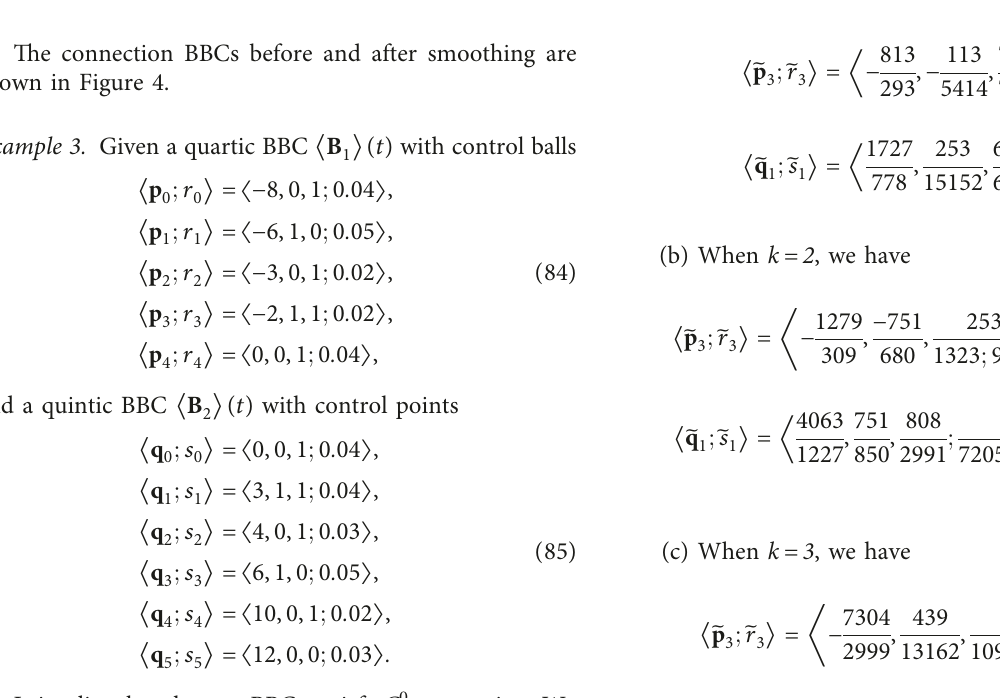
Figure 4: Smoothing two connected BBCs from C 0 to C 1 by minimizing the curve attractor. (a) C 0 connection. (b) C 1